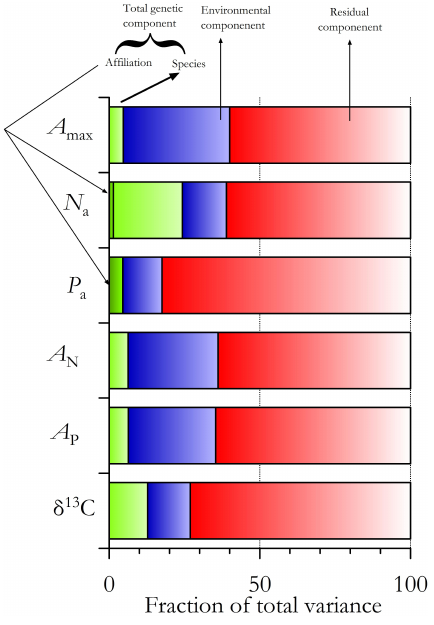
Figure 9. Partitioning of the total variance for photosynthesis- associated foliar properties into genetic (green), environmental (blue) and residual (red) components with the genetic component further divided into the variations between versus within vegetation formation affiliation (each species having being identified as princi- pally associated with either forest or savanna). A max denotes light and CO 2 saturated (maximum) CO 2 assimilation rate; N a and P a represent the nitrogen and phosphorus composition of the leaves on an area (subscript “a”) basis; A N and A P represent the photosyn- thetic nitrogen and phosphorus-use efficiencies (viz. A max / N a and A max / P a ) with δ 13 C a measure of the leaf 13 C / 12 C composition.